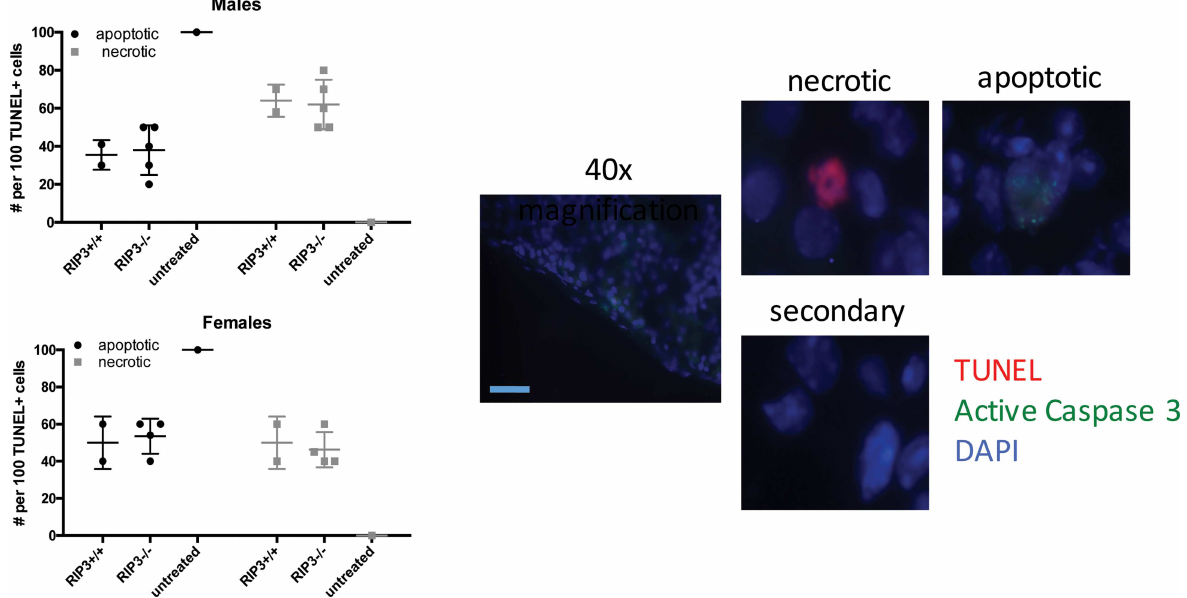
Fig 4. Absence of RIPK3 does not cause a reduction in necrotic cell death within the kidney during NTS-nephritis. Percentage of apoptotic and necrotic TUNEL+ cells were determinedby staining for TUNEL (red), active Caspase3 (green), and nuclei (DAPI- blue). 10x size bar = 200 μ m, 40x size bar = 50 μ m. At least 50 TUNEL+ cells were recordedfor each mouse, N = 5 mice per strain. Necrotic nuclei were characterized by only TUNEL+ staining, while apoptotic cells were positive for both TUNEL and active-caspase 3. Percentagesof positive cells between B6 and RIPK3-/-, in each sex were not statistically significant (p (cid:21) 0.05) as determinedby T-test. Data is representedas Mean ± SEM of 2–5 mice per group. Experiments were repeated at least twice.